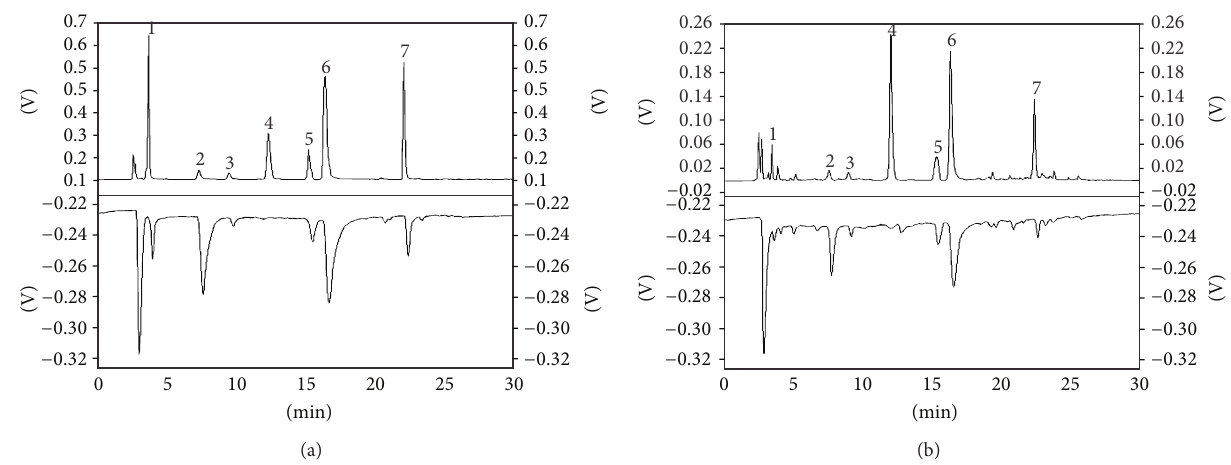
Figure 8: Chromatograms at 278 nm (upper traces) and online DPPH quenching profiles (lower traces) for mixed catechin standards (a) and a tea sample ((b) Bi luo chun). 1: gallic acid; 2: EGC; 3: catechin; 4: caffeine; 5: EC; 6: EGCG; 7: ECG.